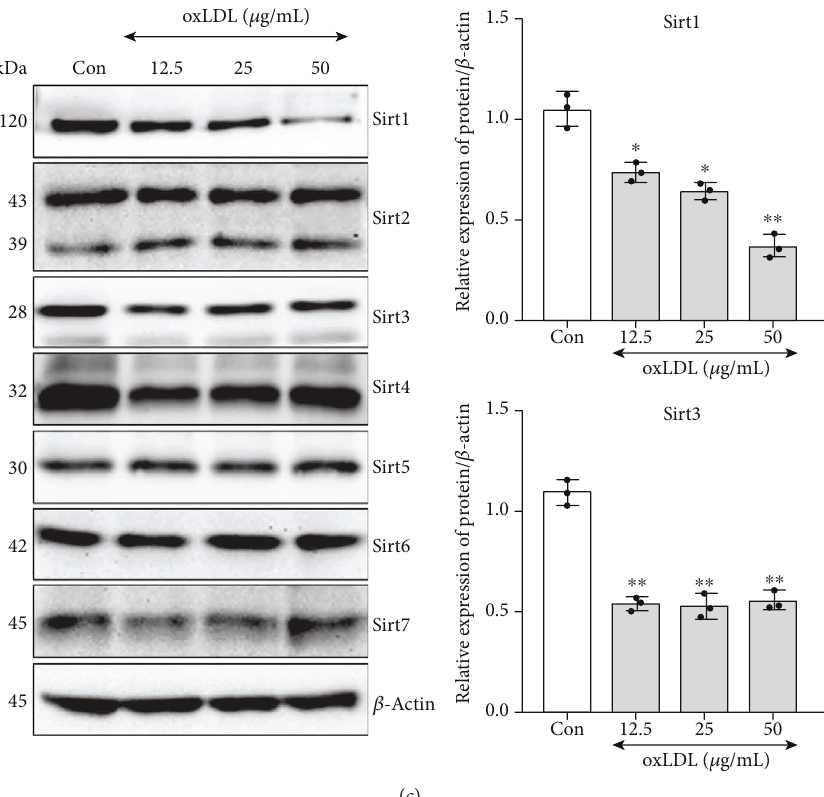
Figure 3: oxLDL regulated expression of toll-like receptor family, ROS-related genes, and sirtuin family as well as activation of Src. After oxLDL stimulation, the mRNA or protein expression of genes was detected by real-time PCR or western blot in VSMCs. The phosphorylation of Src was detected using western blot. The untreated group served as control (Con), and β -actin served as an internal reference gene to normalize protein expression. All of the real-time PCR results were calculated by 2 - ΔΔ CT method; the western blot results were calculated using grayscale value. (a) The mRNA expression of the toll-like receptor family ranging from Tlr1 to Tlr13 . ( n = 3 per group, results were expressed as mean ± SD ; ∗ P < 0 : 01 , as compared with the Con group.) (b) Upper: the phosphorylation of Src (Tyr-418, Y418) was detected after 1-hour stimulation by di ff erent doses (12.5, 25, and 50 μ g) of oxLDL in VSMCs. Bottom: the protein expression of ROS generation (Nox2 and Nox4) and elimination-related (Mnsod) genes in VSMCs, after stimulating by di ff erent doses (12.5, 25, and 50 μ g) of oxLDL for 48 hours. (c) After incubation with di ff erent doses (12.5, 25, and 50 μ g) of oxLDL, the protein levels of the sirtuin family (Sirt1-7) were measured. ( n = 3 per group, results were expressed as mean ± SD ; ∗∗ P < 0 : 01 as compared with the Con